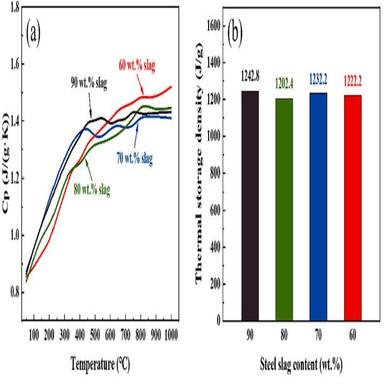
(a) Specific heat and (b) thermal storage density in the temperature range of 50 ◦C–1000 ◦C of samples after sintering at 1200 ◦C with different pretreated steel slag contents.